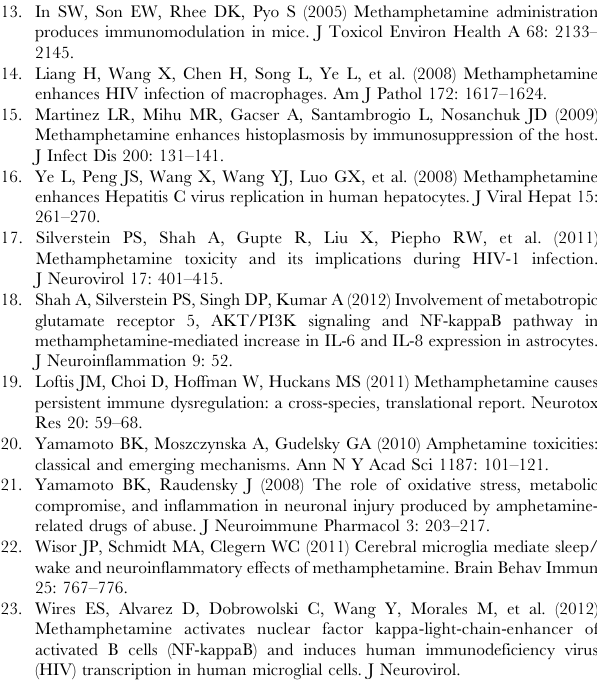
Table S1 Body weight information. Table S2 Cytokine expression in the